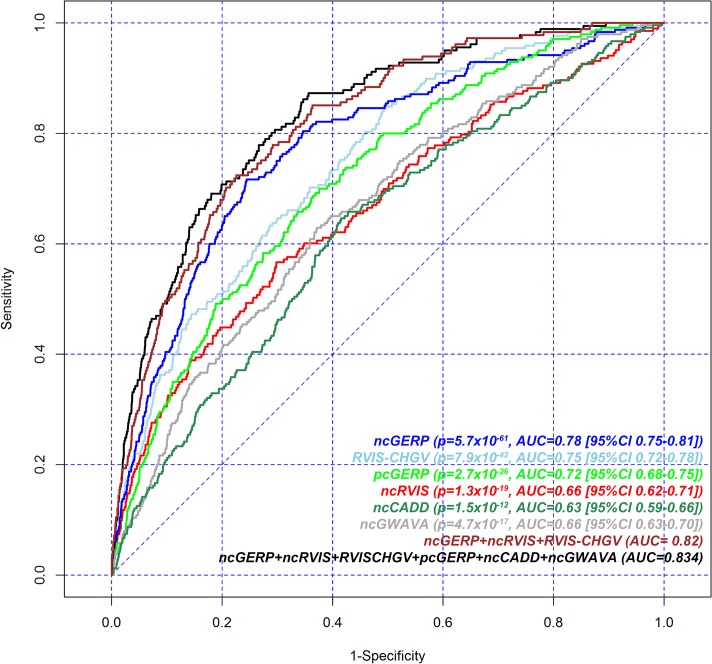
Receiver operating characteristic (ROC) curves to measure the ability of RVIS-CHGV, ncRVIS, pcGERP, ncGERP, ncCADD, ncGWAVA scores and two joint models to discriminate genes reported among ClinGen’s dosage sensitivity map from the rest of the human genome.Here, for a given score, all assessable genes were used. To obtain the presented levels of significance, we use a logistic regression model to regress the presence or absence of a gene among the ClinGen dosage sensitivity map list on each of the genic scores.